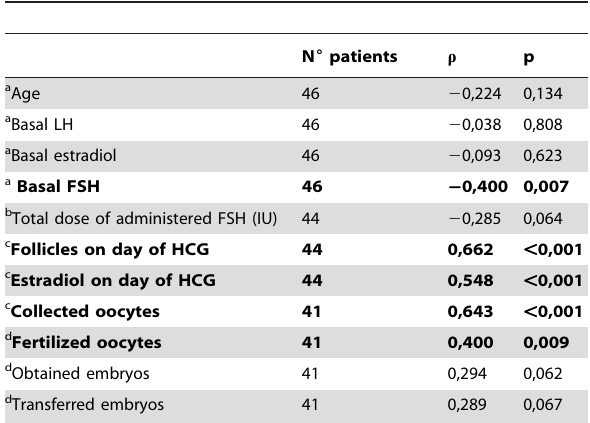
Table 3. Correlations between AMH serum level and pre/post treatment